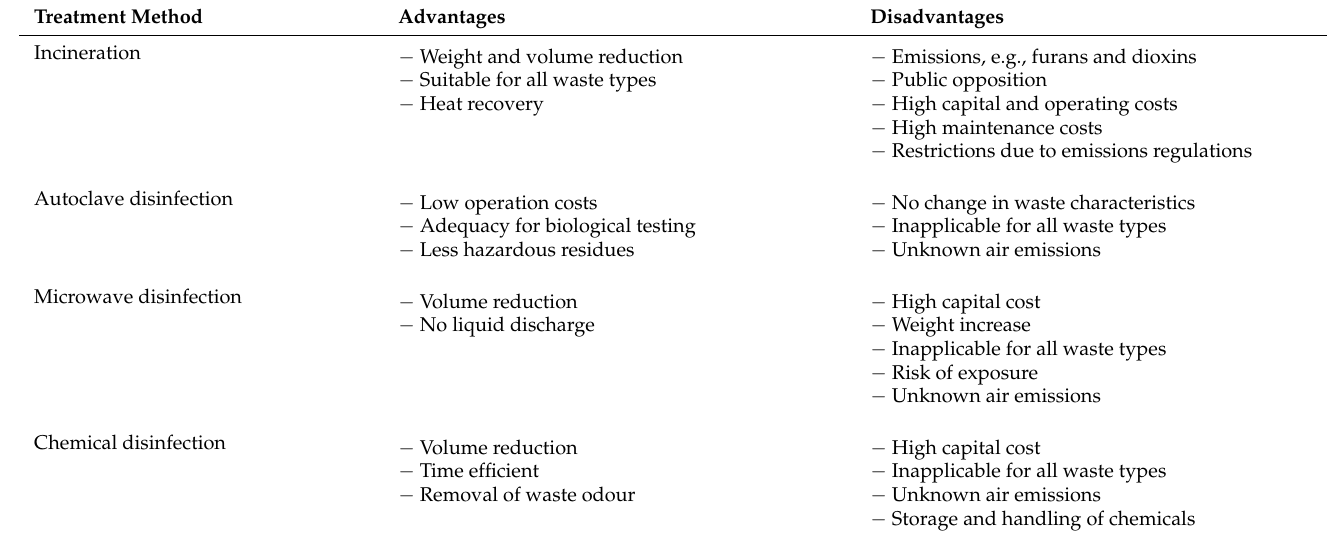
Table 2. A comparison between treatment methods in terms of advantages and